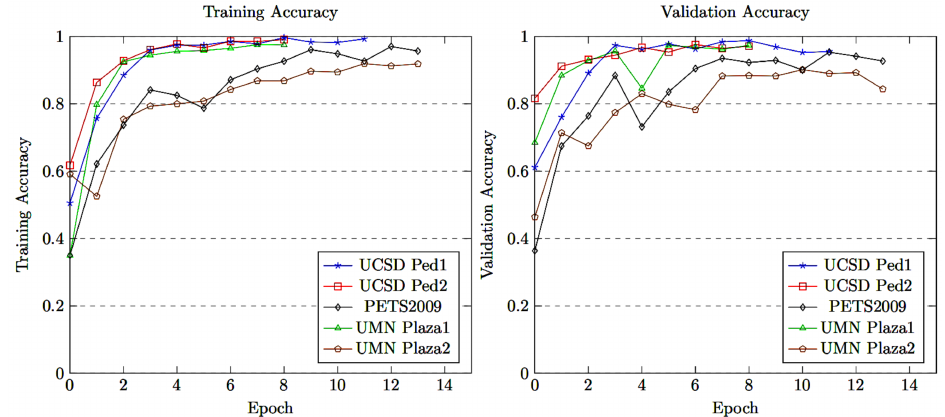
Figure 7. Training and validation accuracy of MCMS-BCNN-Attention +